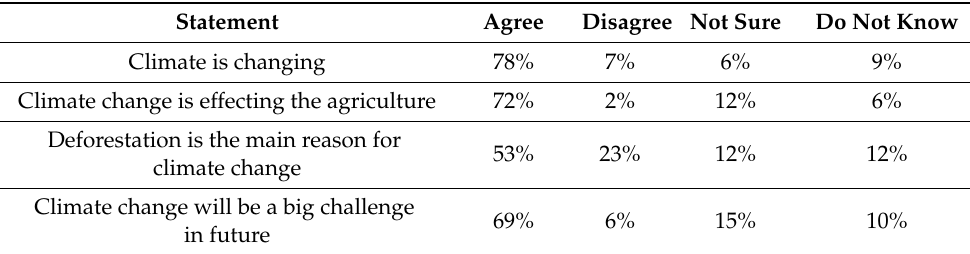
Table 3. Perceptions of farmers about climate change information and awareness.